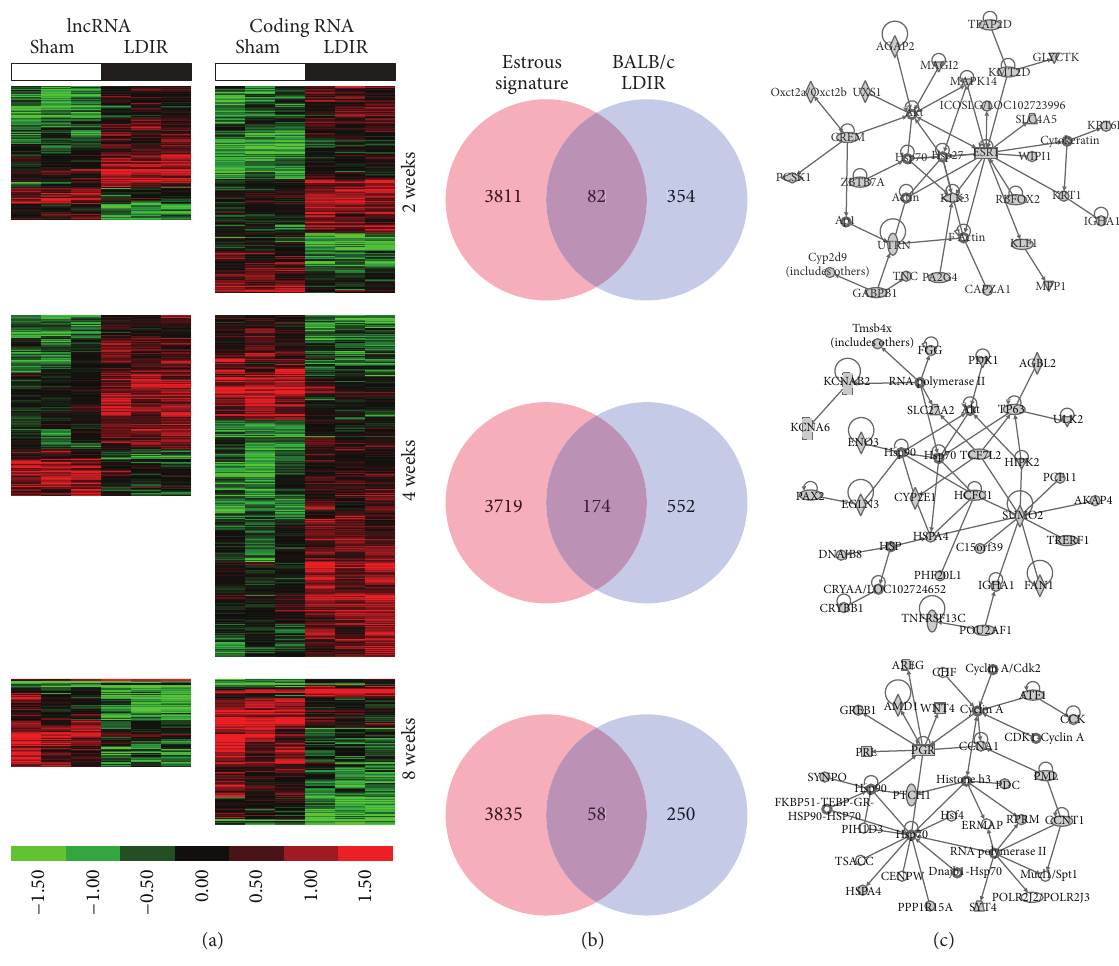
Figure 2: Significant lncRNA and coding RNA expression changes after LDIR exposure in mammary tissues of BALB/c mice. (a) Hierarchical clustering of lncRNAs (left) and coding RNAs (right) differentially expressed (fold-change 1.5; 𝑝 < 0.05 ) in mammary gland tissues of BALB/c mice at 2, 4, and 8 weeks after sham or LDIR exposure. Increased expression indicated in red and decreased expression in green. (b) Comparison of genes differentially expressed after low-dose radiation at each timepoint with a gene signature containing genes whose expression significantly changes in the mammary gland across the female estrous cycle. (c) The most significant gene interaction networks of estrous cycle independent genes differentially expressed after LDIR at 2, 4, and 8 weeks after exposure (see Figure S3 for annotation of molecular shapes used in the